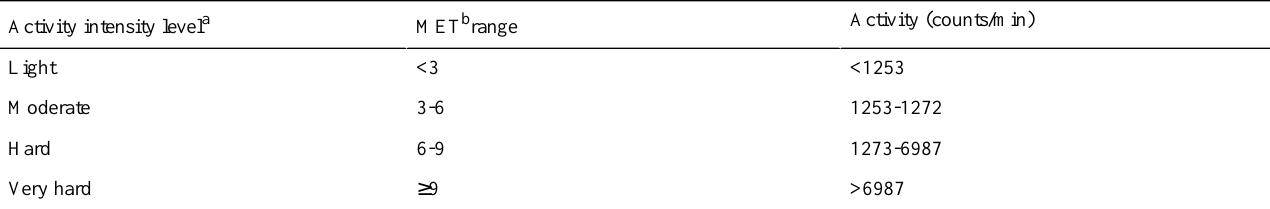
Table 2. Movn activity count thresholds for classifying activity intensity level.